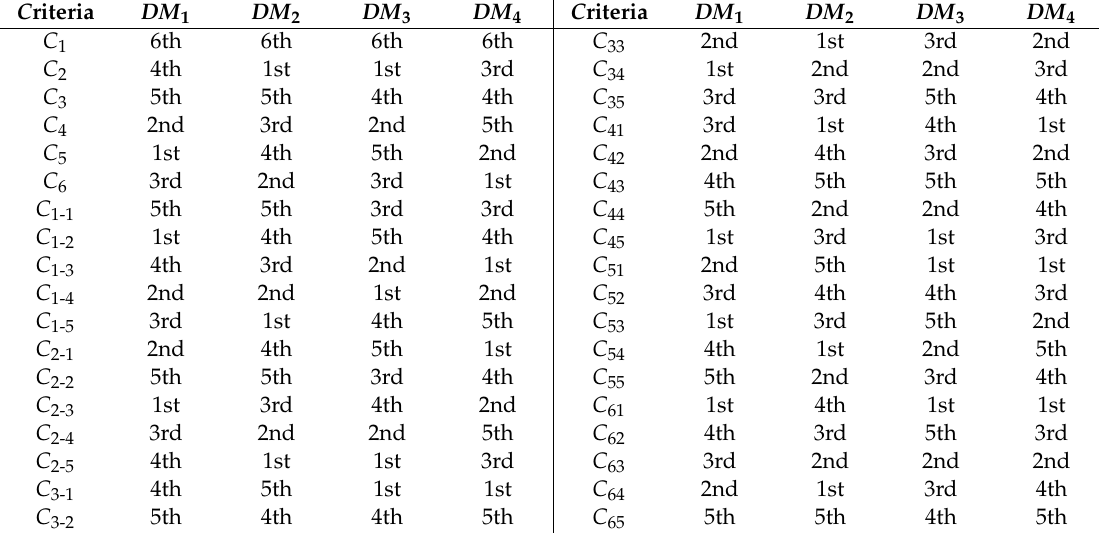
Table 1. Raw data of the decision-makers’ (DMs) rankings.